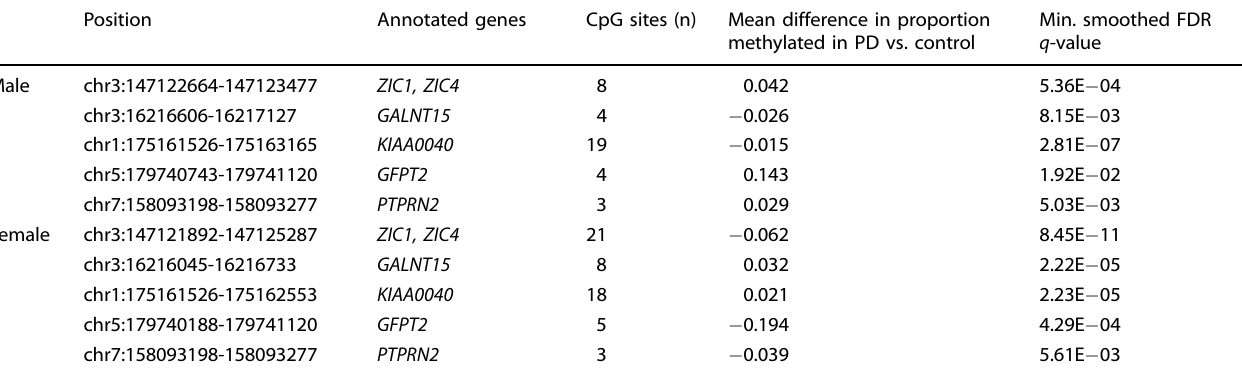
Table 2. Differentially methylated regions (DMRs) by Parkinson ’ s disease. Position Annotated genes CpG sites (n) Mean difference in proportion